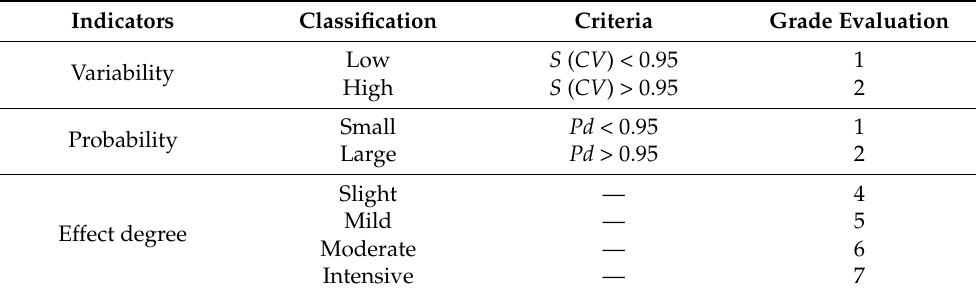
Table A2. Criteria for grading the degree of climate impact in Southwest China.